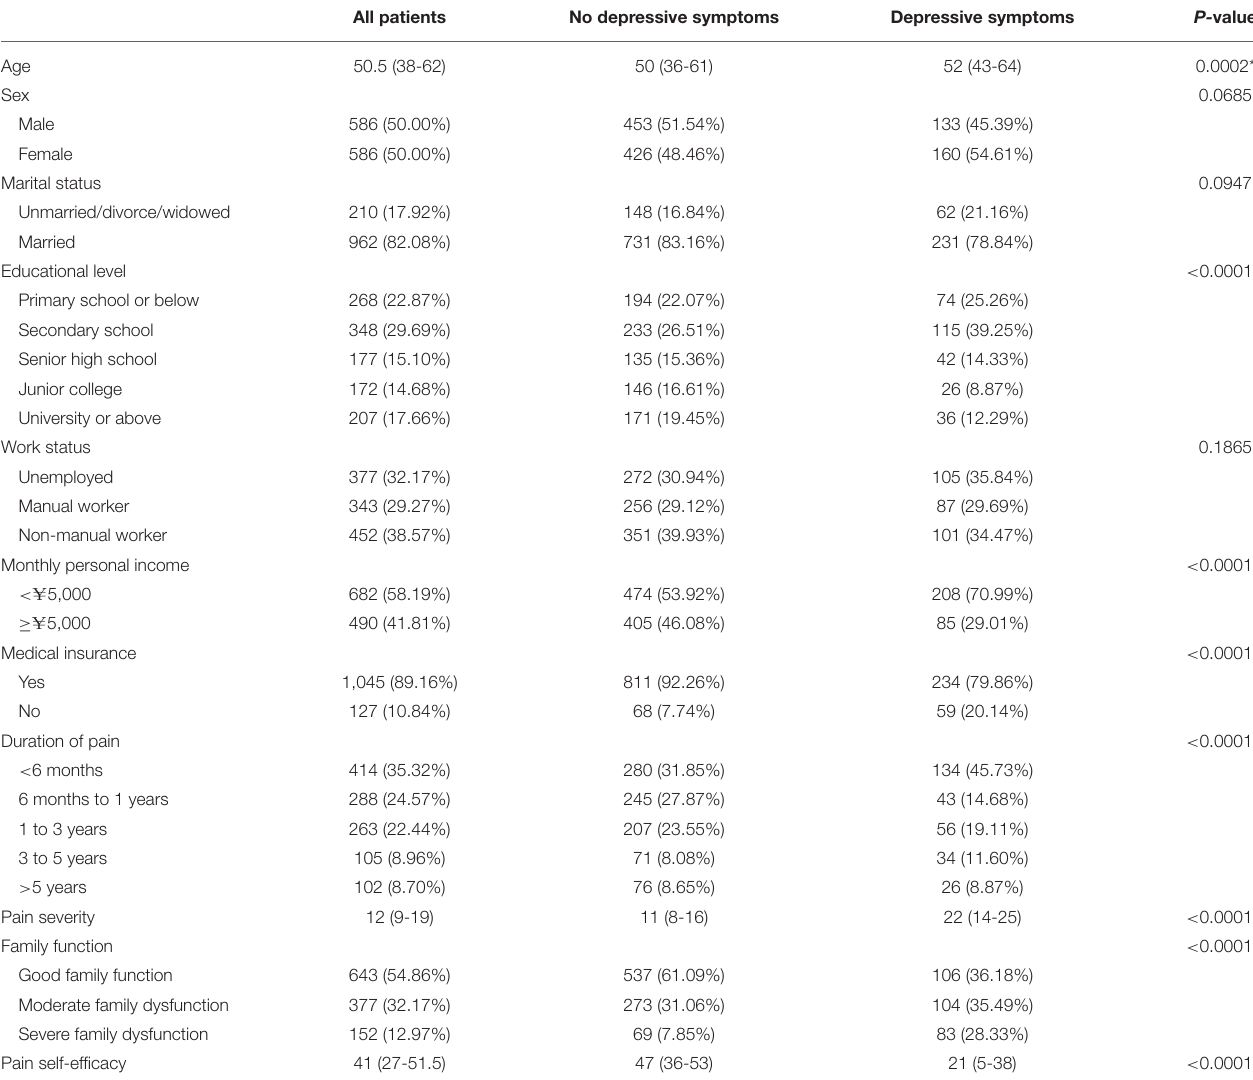
TABLE 1 | Demographic and clinical characteristics of patients with chronic low back pain according to presence of depressive symptoms. All